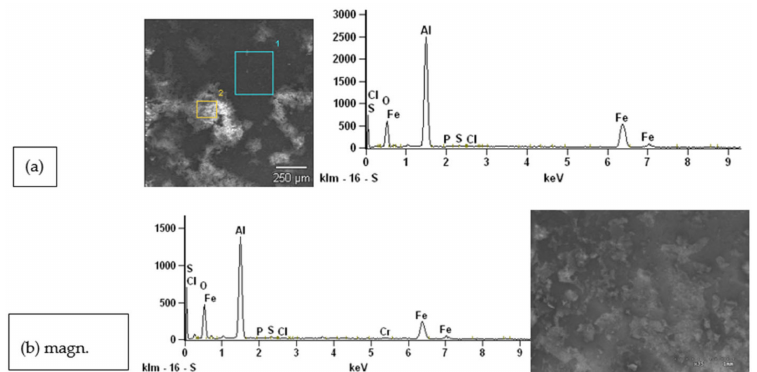
Figure 21. ( a ) Chemical composition of the Fe Al intermetal surface in the pt1 and pt2 planes; ( b ) microscopic photo (SEM) of the Fe 3 Al intermetal surface.